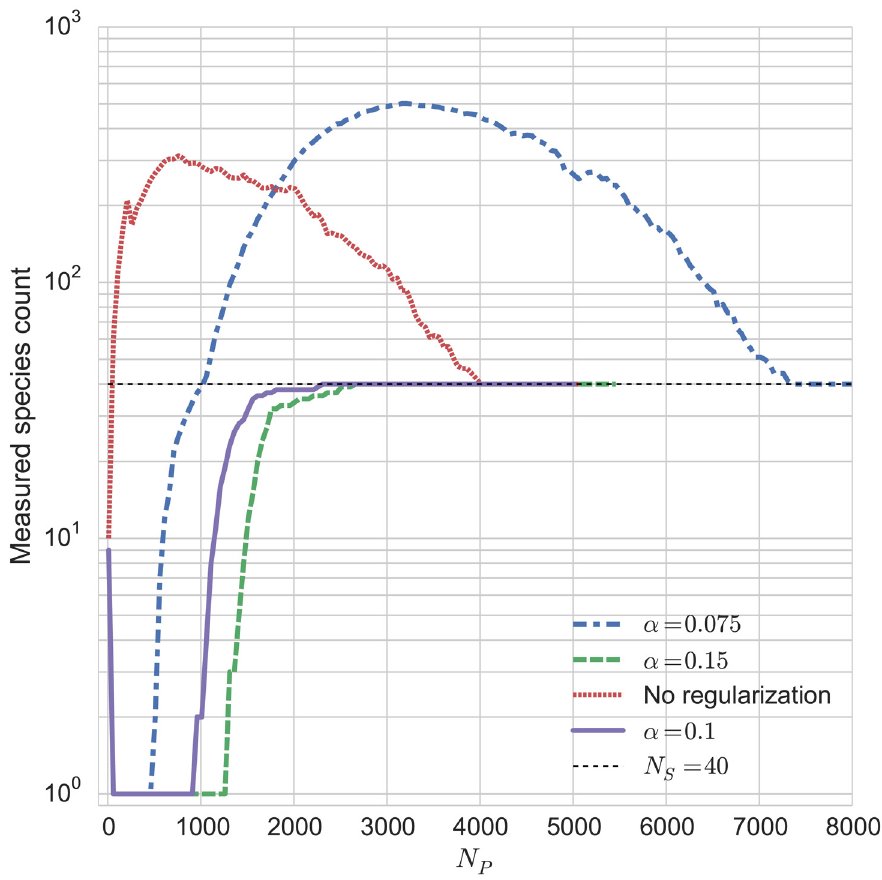
Fig 1. Convergence of the measured number of heritable states as the number of data points is increased. This shows the effect of regularization and of the choice of α on the convergence pattern in this particular test case. The parameters for these data are f 1 = 0.05, m = 0.2, N S =